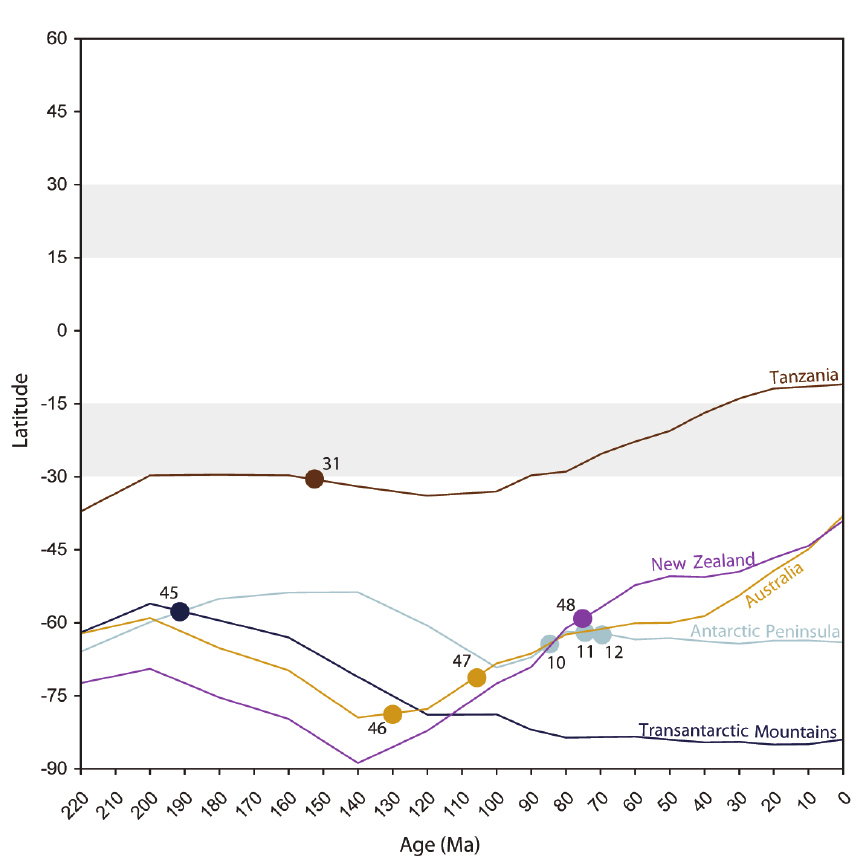
Fig. 5 – Trajectories of localities in the far South Atlantic (Antarctic Peninsula, 10-12) and the eastern Indian Ocean (Transantarctic Mountains, 45; Australia, 46, 47; and New Zealand, 48). The motion of the sites can be compared with the latitudinal shift of Tendaguru (35), a locality in southeastern